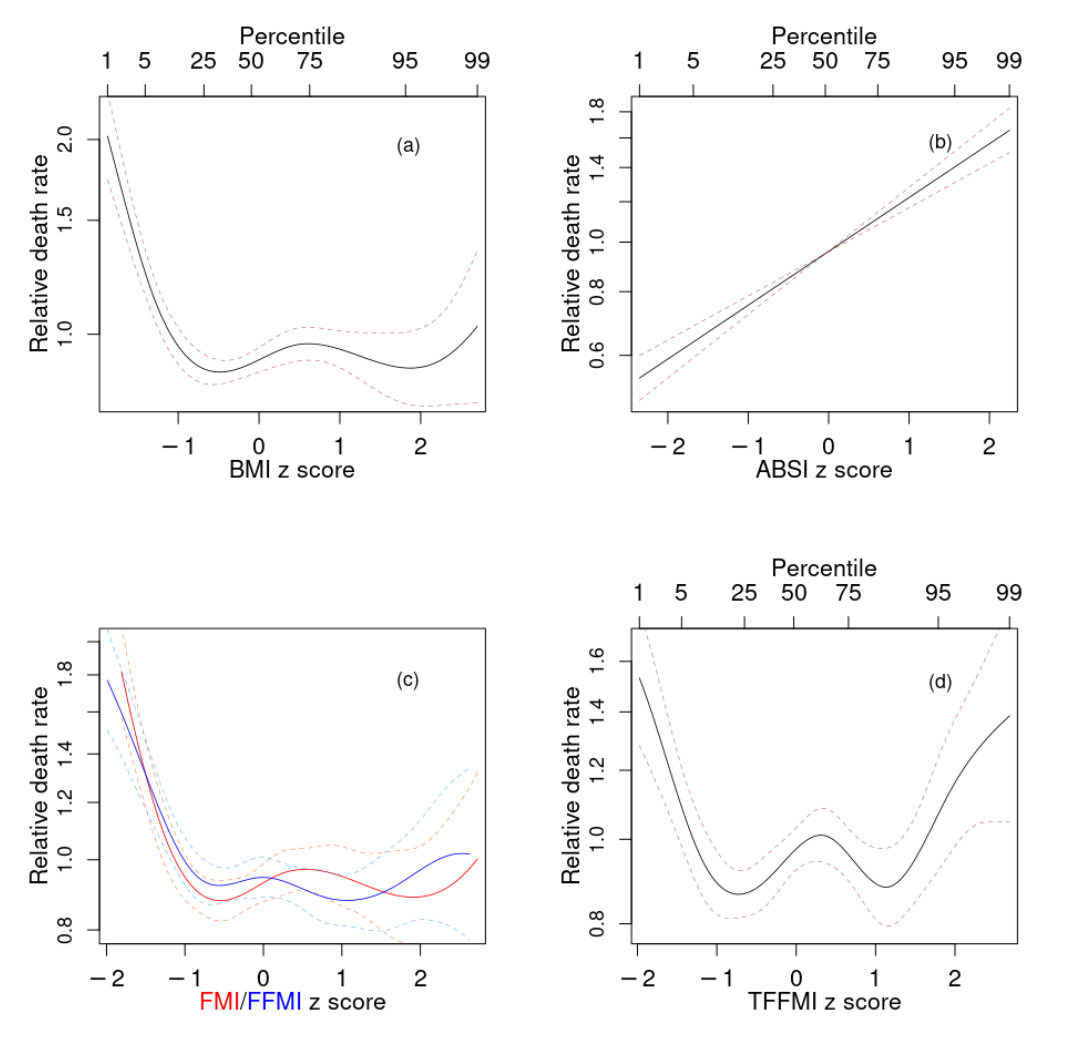
Figure 2. Estimated mortality hazard ratios in NHANES 1999–2006 as nonlinear (penalized spline) functions of ( a ) BMI, ( b ) ABSI, ( c ) FMI (red) and FFMI (blue), ( d ) TFFMI. Dashed lines indicate 95% confidence intervals. NHANES = National Health and Nutrition Examination Survey; BMI = body mass index; ABSI = a body shape index; FMI = fat mass index; FFMI = fat-free mass index; TFFMI = trunk fat-free mass